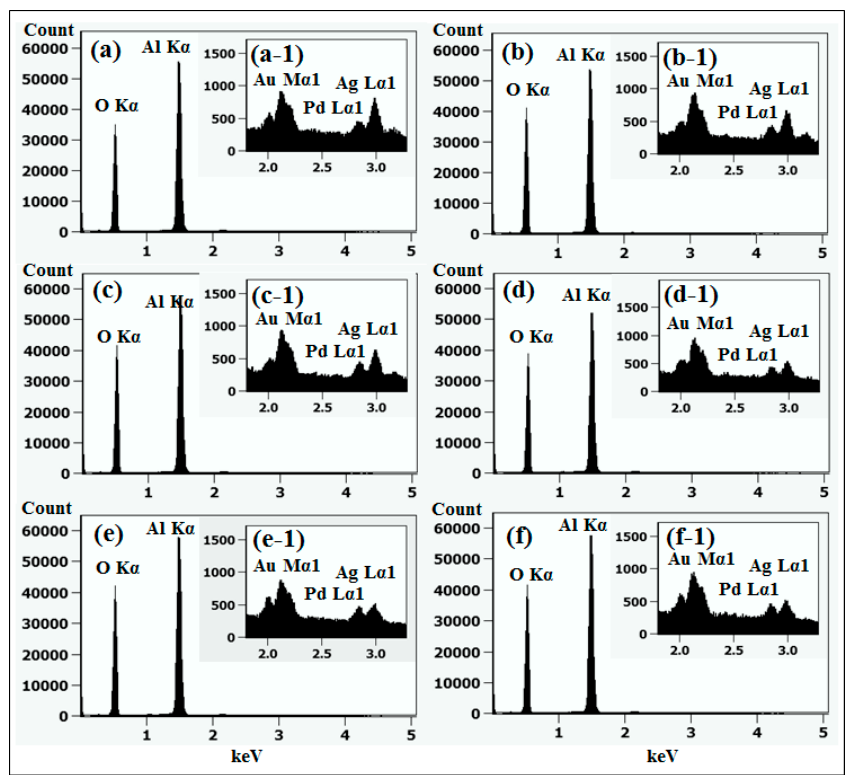
Figure A9. ( a – f ) EDS spectra of various Pd-Au-Ag nanostructures with tri-layer of Pd-Au-Ag of total thickness 6 nm and equal composition followed by annealing between 400 and 900 °C. ( a - 1 – f - 1 ) Enlarged EDS spectra.